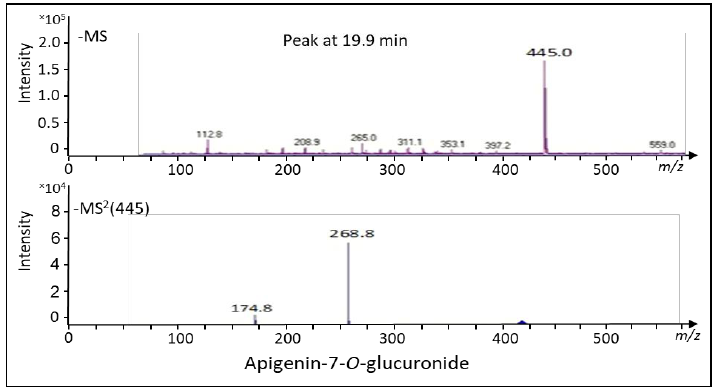
Figure 3. Electrospray ionization mass spectrometry (ESI-MS) and MS/MS fragmentation pattern of the peak released at 19.9 min in the HPLC chromatogram. The peak obtained from Figure 2,c was subjected to analysis in the negative mode of the ion for peak at 19.9 min via ESI-MS and MS/MS technique. The obtained m/z values reflect the molecular mass of apigenin-7- O- glucuronide ( m/z = 445.0).